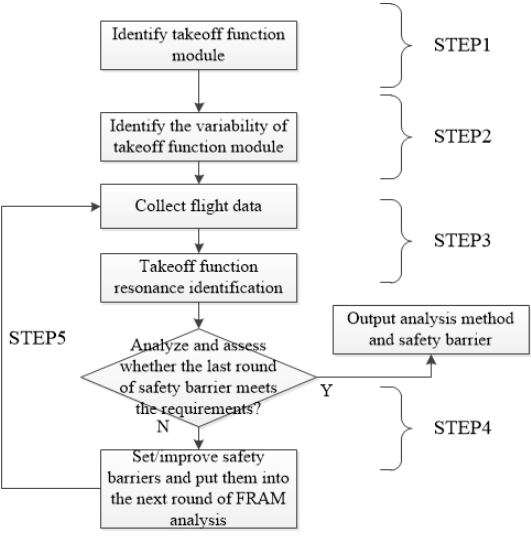
Figure 5. Take-off safety analysis based on the improved FRAM